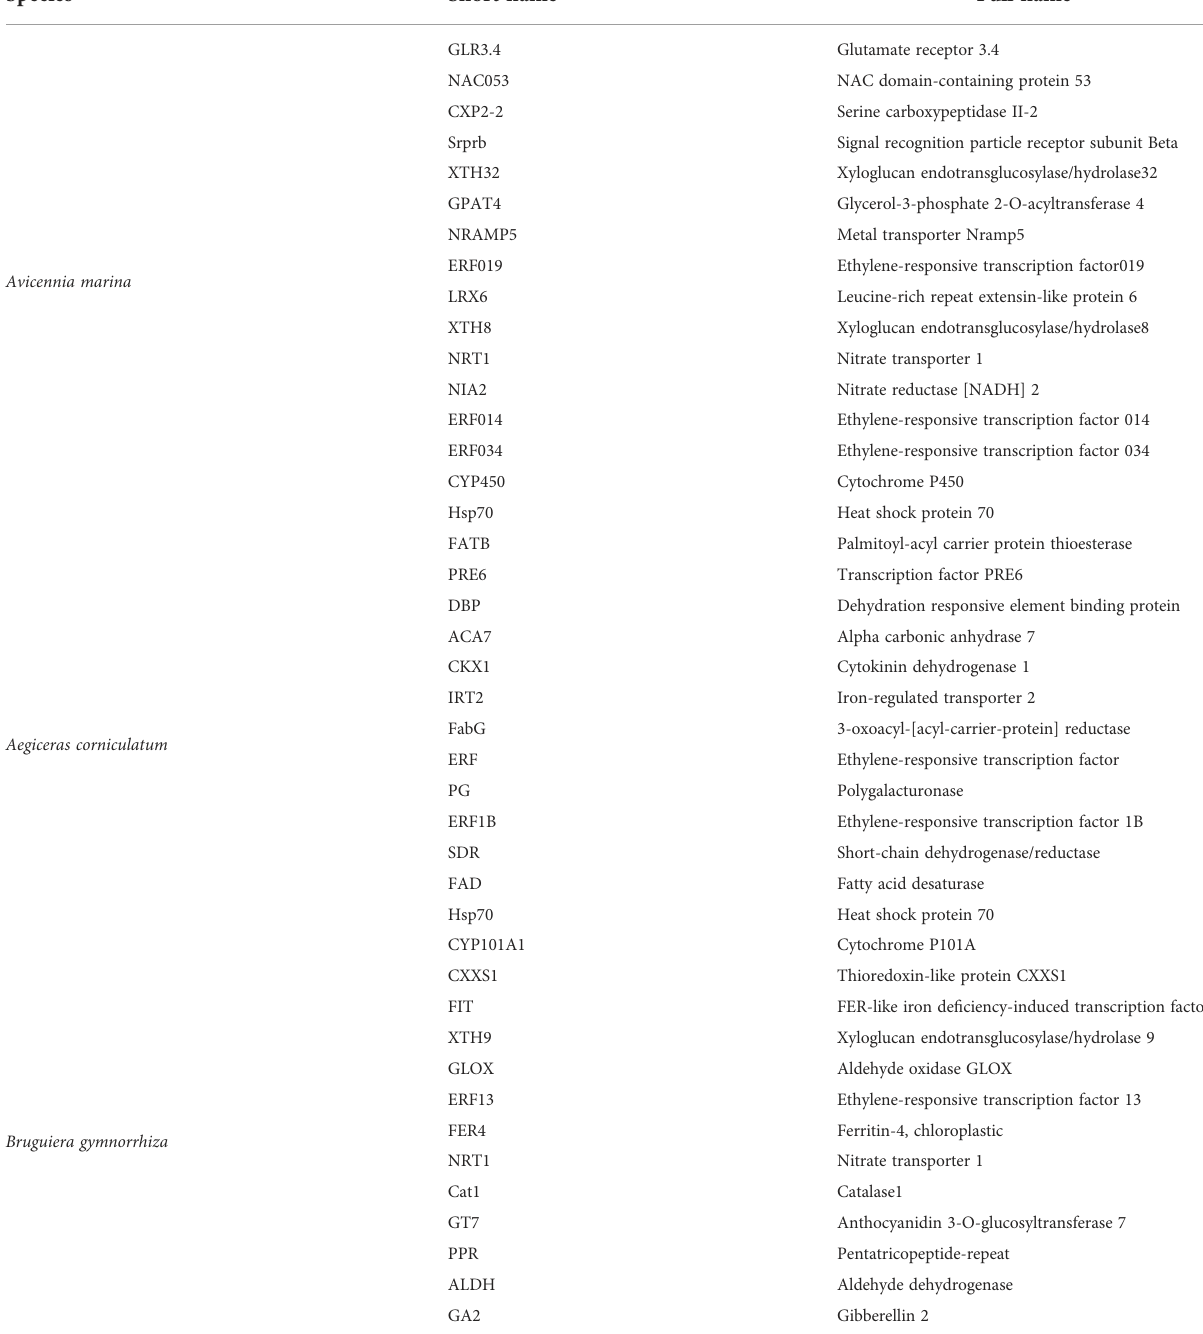
TABLE 4 List of prominent (eightfold) differentially expressed genes (DEGs).